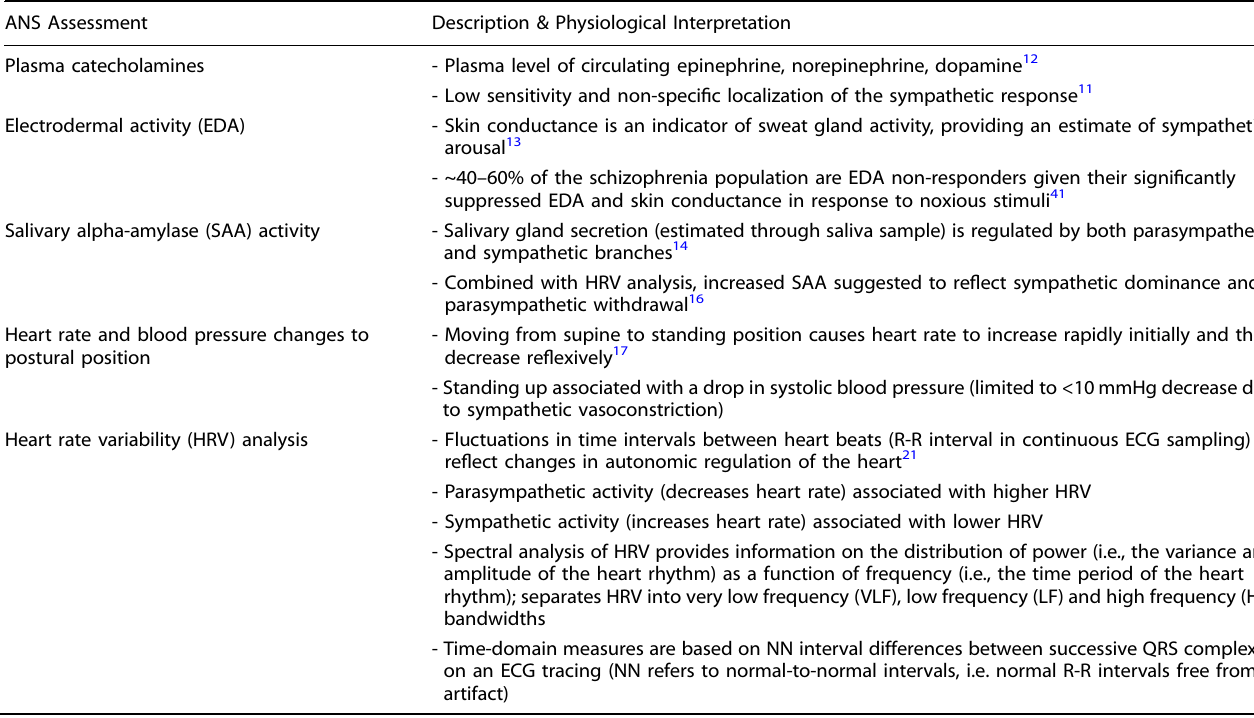
Table 1. Methods of assessing autonomic nervous system